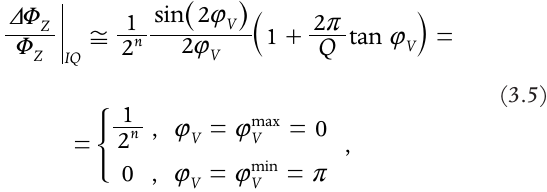
Table 1. With reference to the caption of Figure 3: a quadrupolar probe is connected to a uniform or IQ ADC (bit resolution n ). Data are shown for the optimal working frequency, f , that minimizes the inaccuracy in the measurement of permittivity, Df opt f , that limit the inaccuracies of permittivity and conductivity, Df max concrete, with n =8 and n